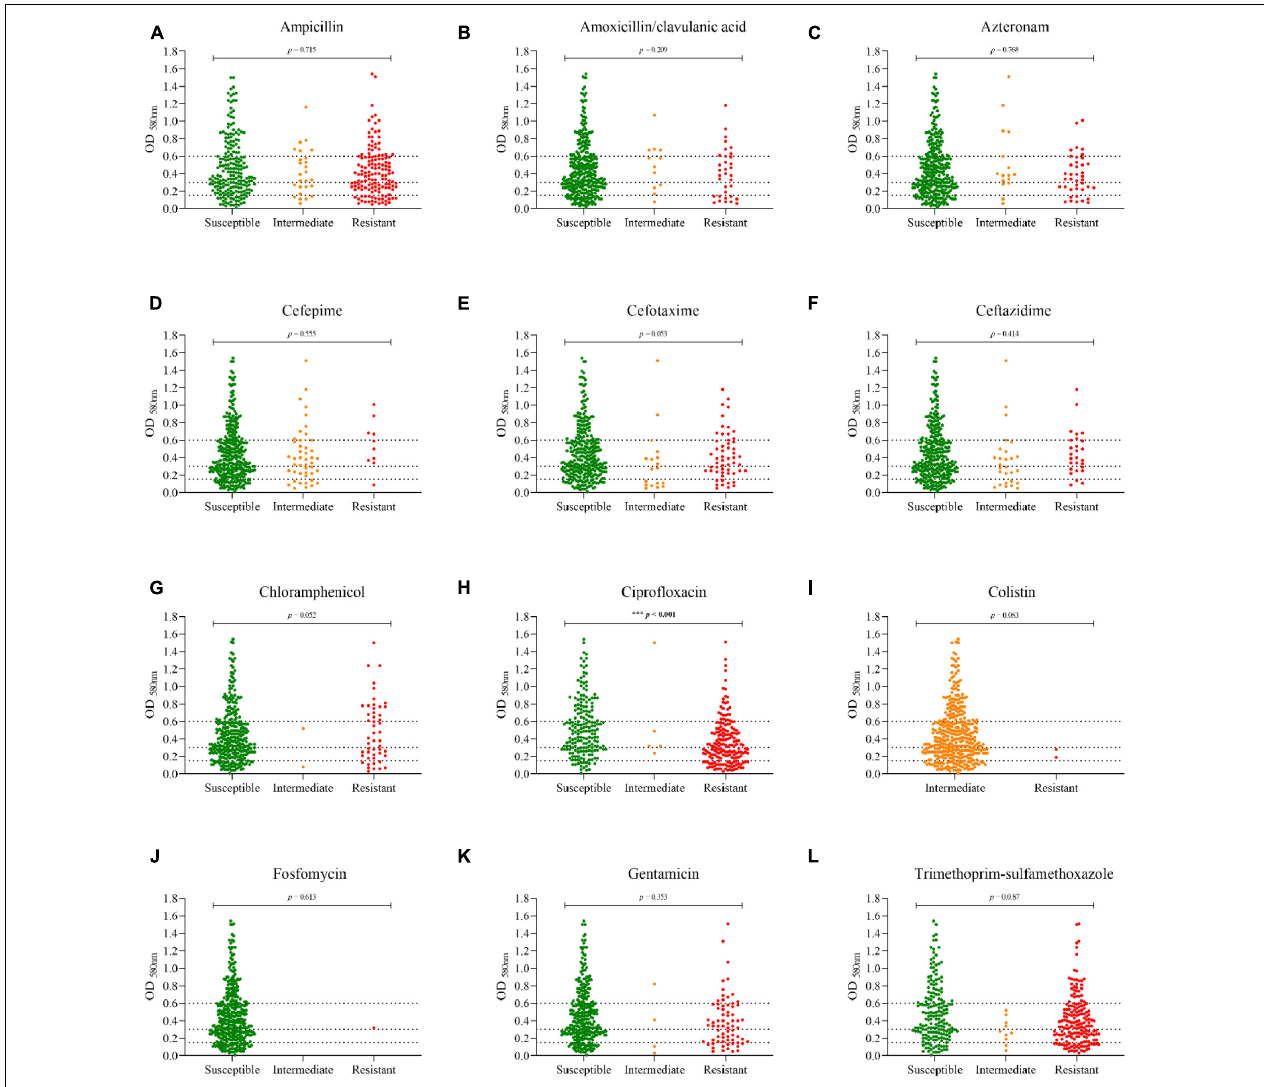
FIGURE 3 | Distribution of biofilm formation among the different antibiotic resistance profiles. (A) Ampicillin; (B) Amoxicillin/Clavulanic acid; (C) Aztreonam; (D) Cefepime; (E) Cefotaxime; (F) Ceftazidime; (G) Chloramphenicol; (H) Ciprofloxacin; (I) Colistin; (J) Fosfomycin; (K) Gentamicin; (L) Trimethoprim-sulfamethoxazole. The dotted lines indicate the cut-off points for each biofilm category [non-biofilm formers (OD ≤ 0.150), weak biofilm formers ( ≥ 0.151 OD ≤ 0.300), moderate biofilm formers ( ≥ 0.301 OD ≤ 0.60), or strong biofilm formers (OD ≥